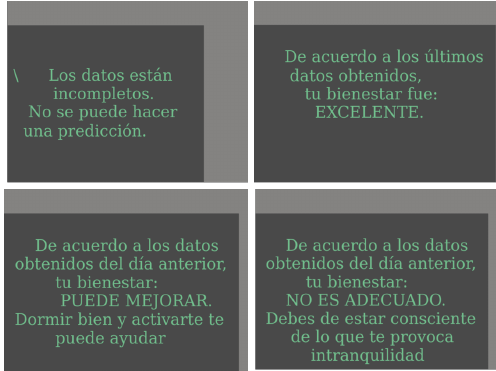
Figure 14. Classification